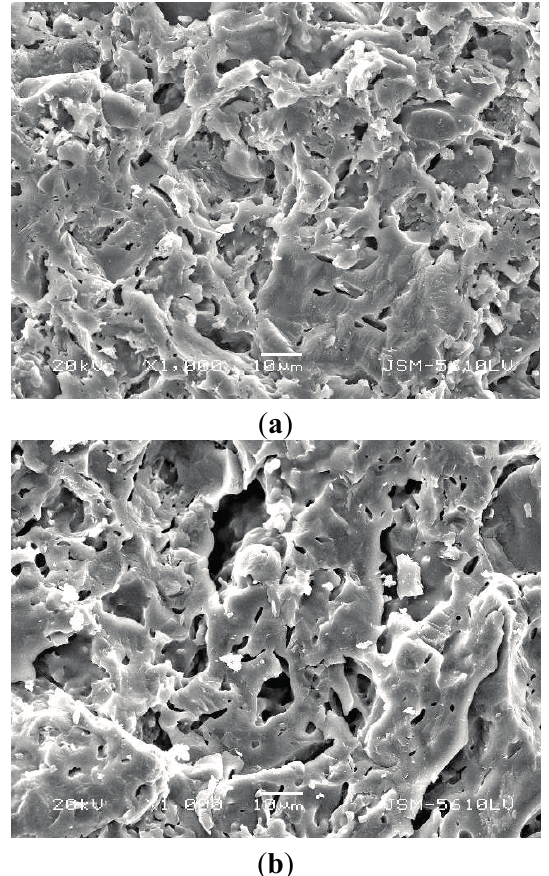
Figure 2. SEM micrographs of LWA containing sludge with different MSWI fly